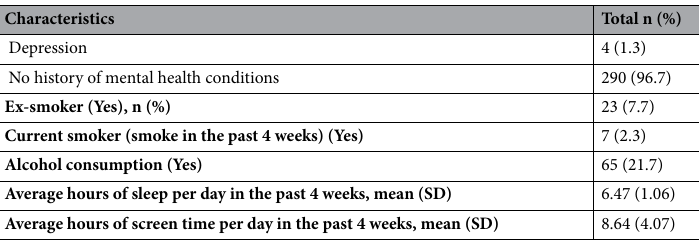
Table 2. Characteristics of the participants (N = 300). a Public housing developed by Housing & Development Board